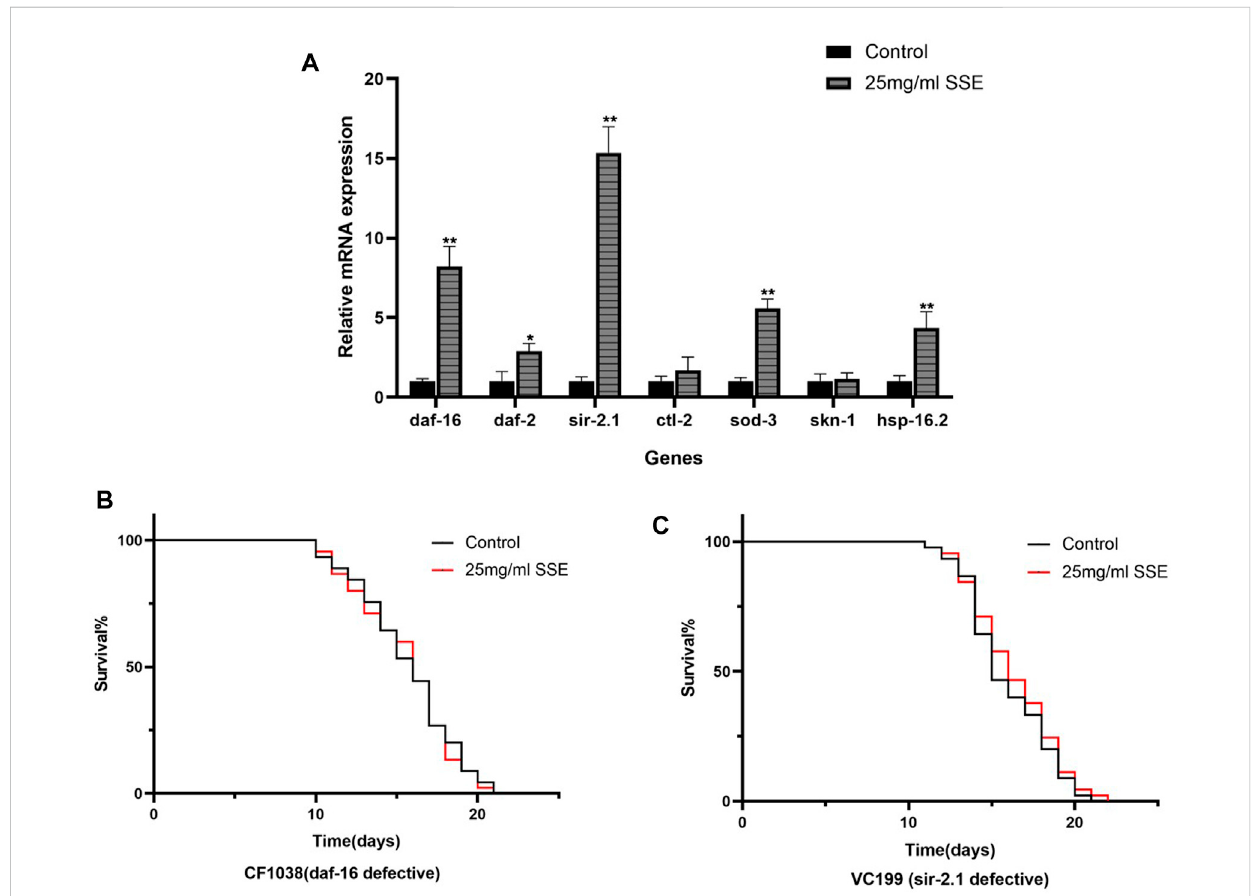
FIGURE 7 Mechanism of SSE-mediated longevity. (A) Effect of orange extracts on age-related gene expressions in Caenorhabditis elegans . (B) Effect of SSE treatment on lifespan of daf-16 defective (CE1038) worms. (C) Effect of SSE treatment on lifespan of sir-2.1 defective (VC199) worms. * p ≤ 0.05, ** p ≤